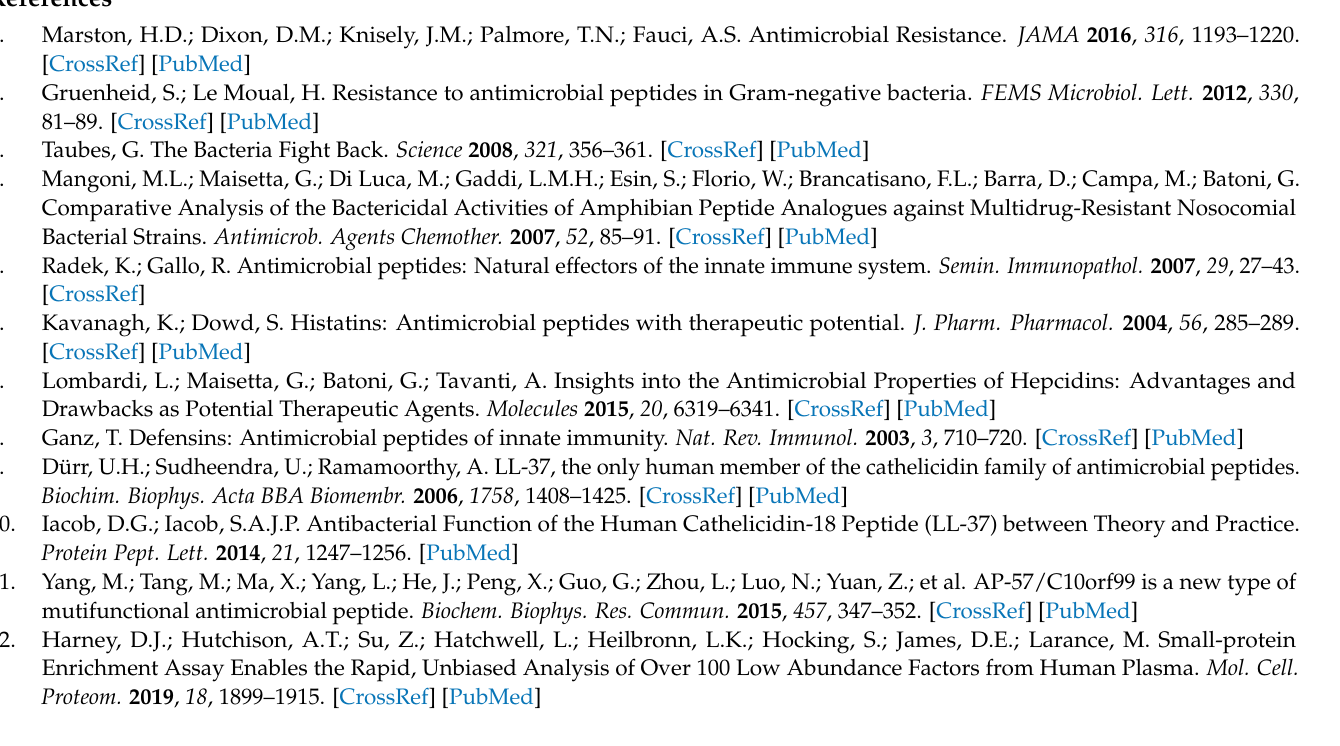
corresponding to the predicted α helix when analyzed by CD spectroscopy. Figure S3: Size exclusion chromatography of the purified peptides. Figure S4: Mass spectra of the AP-64 and Gm94. Figure S5: Antibacterial ability test of indicated proteins toward DH5a cells using the Oxford cup method. Figure S6: Representative bright-field microscopic images of DH5a cells treated with different proteins (10 µ M). Figure S7: Representative images of O157:H7, Vibrio cholerae, Pseudomonas aeruginosa, Staphylococcus aureus and Listeria monocytogenes cells after a 4-h treatment with indicated proteins at a concentration of 10 µ M. Figure S8: Effect of AP-64 and Gm94 on yeast cell viability. Figure S9: Effect of AP-64 and Gm94 on T cell viability. Figure S10: Effect of AP-64 and Gm94 on Hacat cell viability. Figure S11: Effect of AP-64 and Gm94 on MEF cell